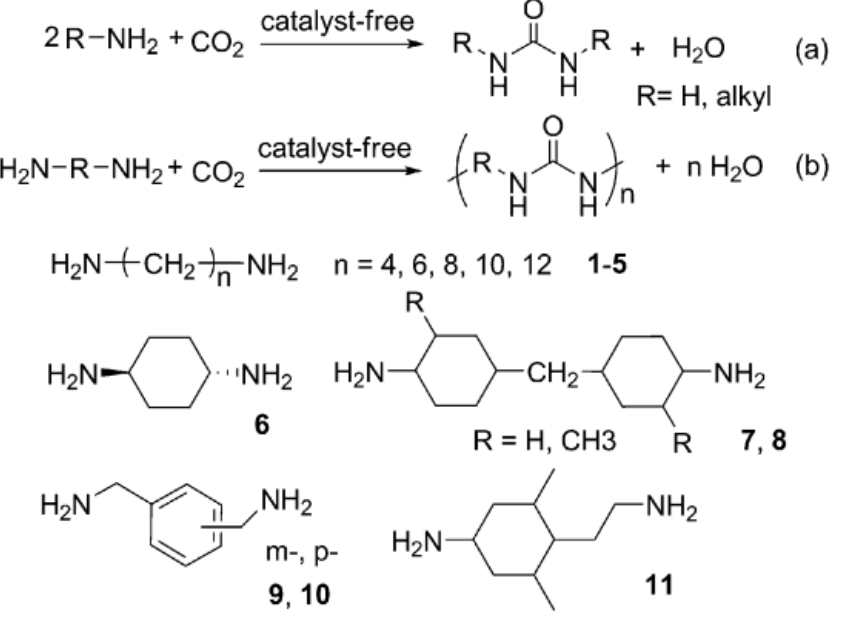
Figure 16. Synthesis of urea, urea derivatives or polyureas from different kinds of amines and CO 2 . ( a , b ) are the products from monoamine and diamine reaction. From reference [18].